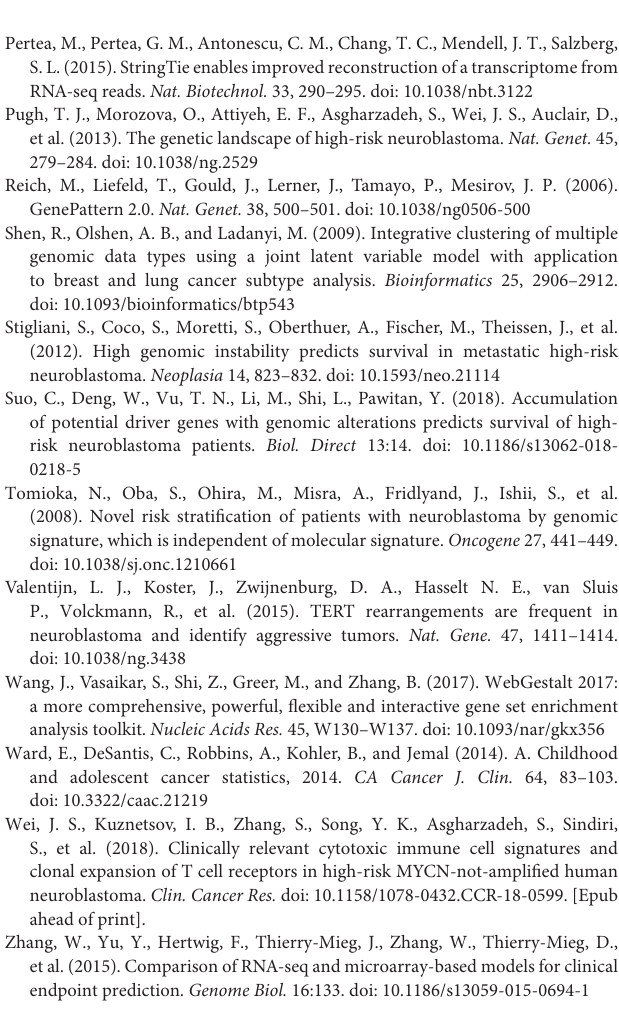
Supplementary Figure S1 | The schematic diagram for Autoencoder algorithm. Supplementary Table S1 | Prognostic subtypes identified by three algorithms. Supplementary Table S2 | Gene features used by SVM. Supplementary Table S3 | CNA genes selected by XGBoost. Supplementary Table S4 | Scores of different cluster numbers. Supplementary Table S5 | Percentages of genes among different thresholds based on